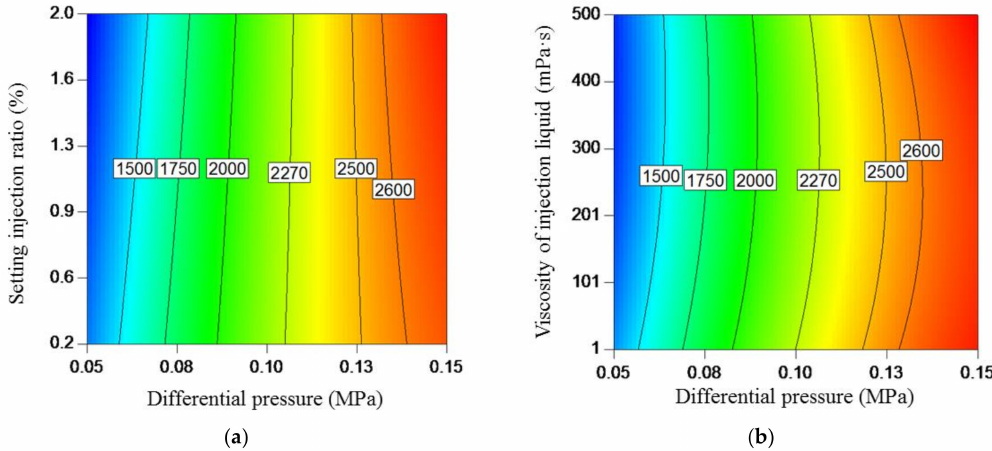
Figure 9. Contour of interaction influence between di ff erent factors and Q il : ( a ) e ff ect of A and B ; ( b ) e ff ect of A and C .